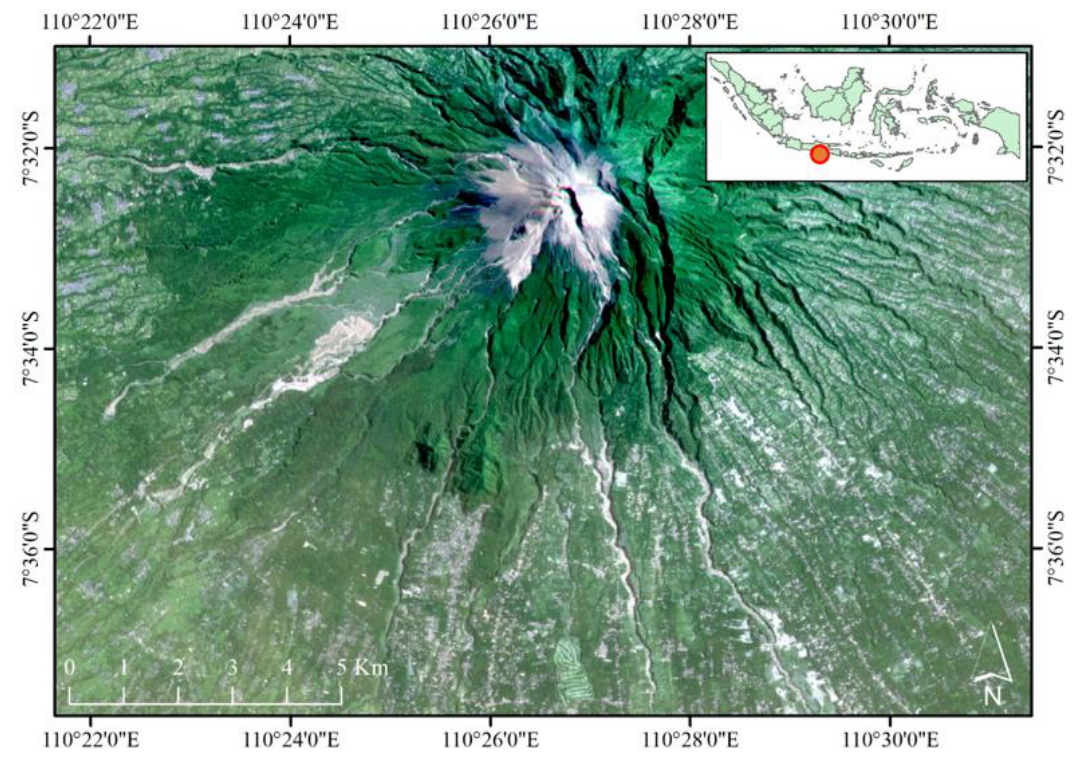
Figure 1. High-resolution (3 m) image from the PlanetScope satellite for the area of Mount Merapi and its surroundings displayed with a true color composite. Dwellings and agricultural land as close as 5 km from the dome translate into high-level disaster risk.